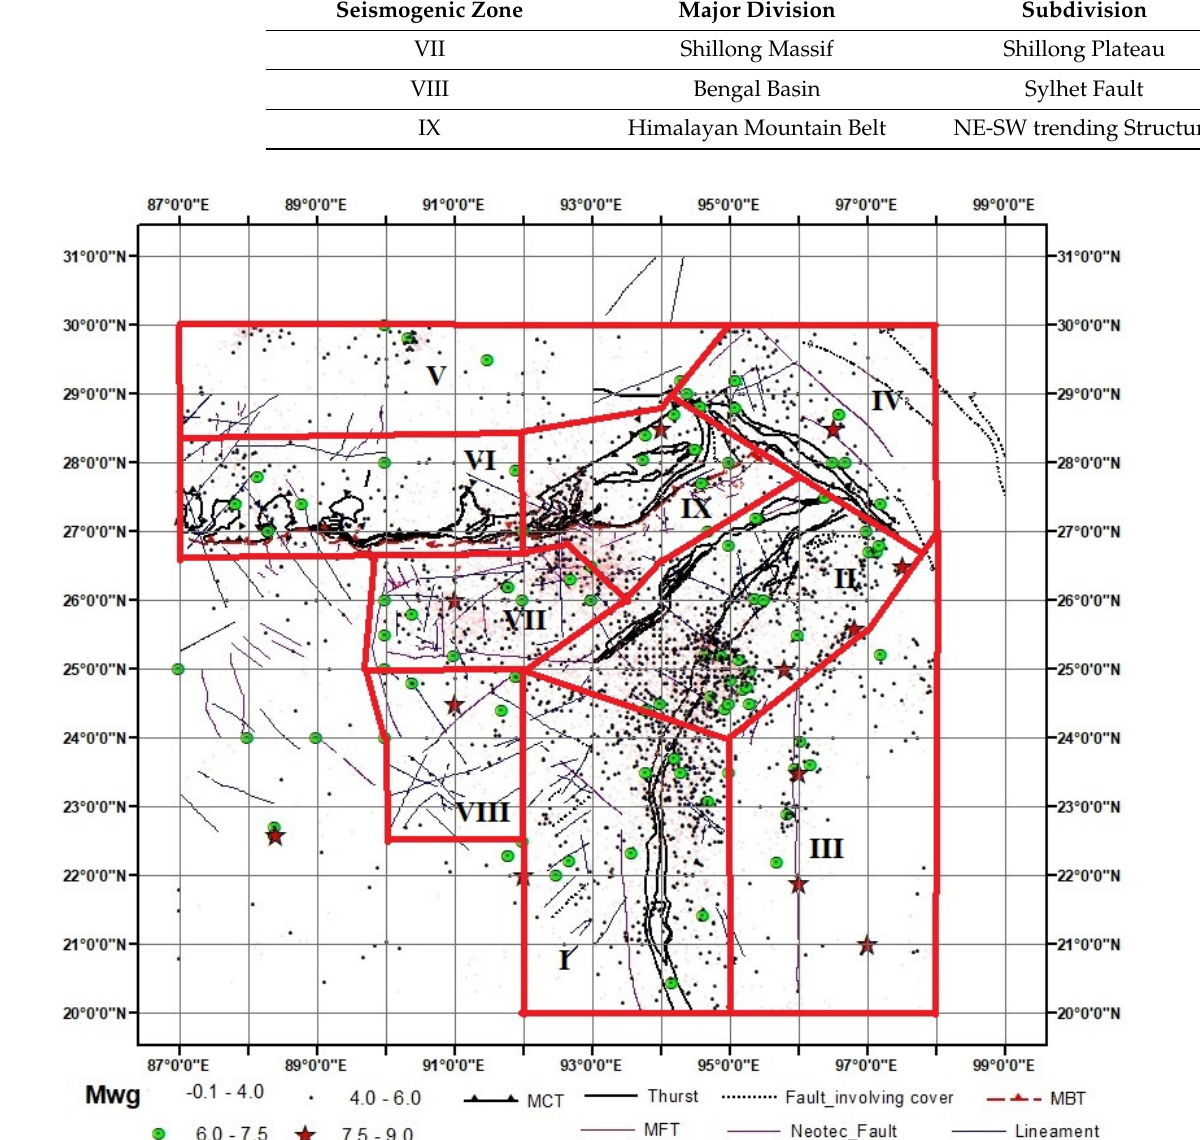
Figure 2. Seismogenic source zones (I-IX) are being considered for Northeast India.